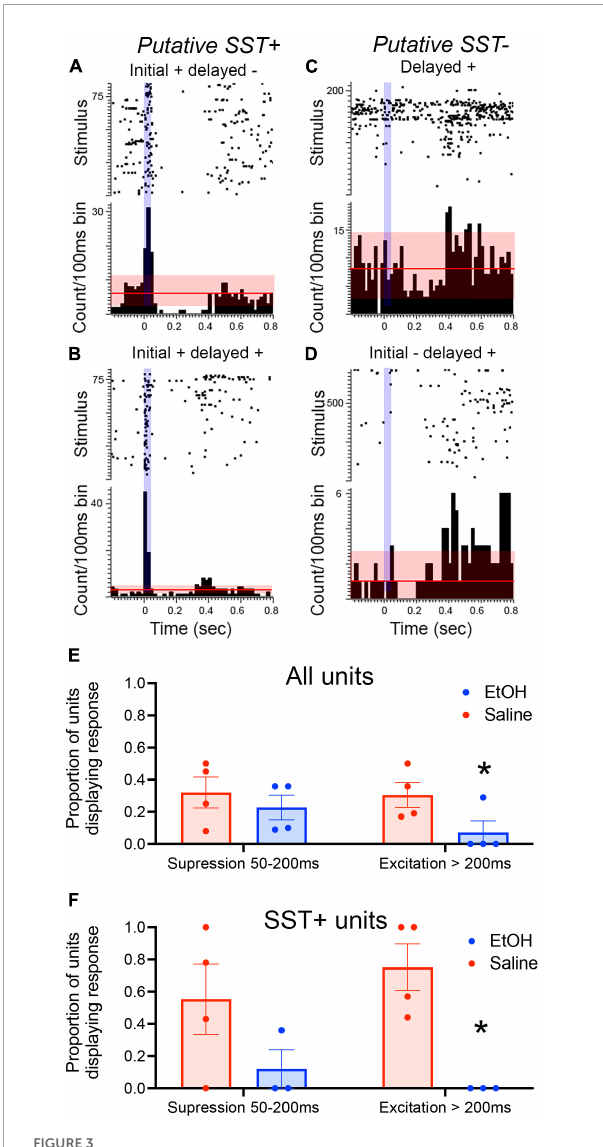
FIGURE3 PFC unit recordings from adult SSTcreXAi32 mice exposed to P7 saline or ethanol ( n = 4 saline mice, n = 47 units; 4 EtOH mice, n = 46 units). (A–D) Rasterplots and peri-stimulus time histogram examples of diverse unit responses to 50 ms, 473 nm light (vertical blue mark) in PFC of saline-treated mice. (A) A putative SST neuron in an ethanol exposed mouse excited during the light followed by suppression (relative to pre-stimulus activity). Horizontal line represents mean spontaneous activity with red shading representing ± 2 S.D. (B) A putative SST neuron in a saline-exposed mouse excited during the light and showing an excitatory rebound 300–400 ms later. (C) An ethanol-exposed non-SST neuron (i.e., no excitation to light) showing a delayed excitatory response 400–500 ms post flash. (D) A saline-exposed non-SST neuron displaying suppression 100–200 ms post-flash and an excitatory rebound at > 400 ms. (E) Proportion of all units showing early ( < 200 ms) suppression and late ( > 200 ms) excitation in